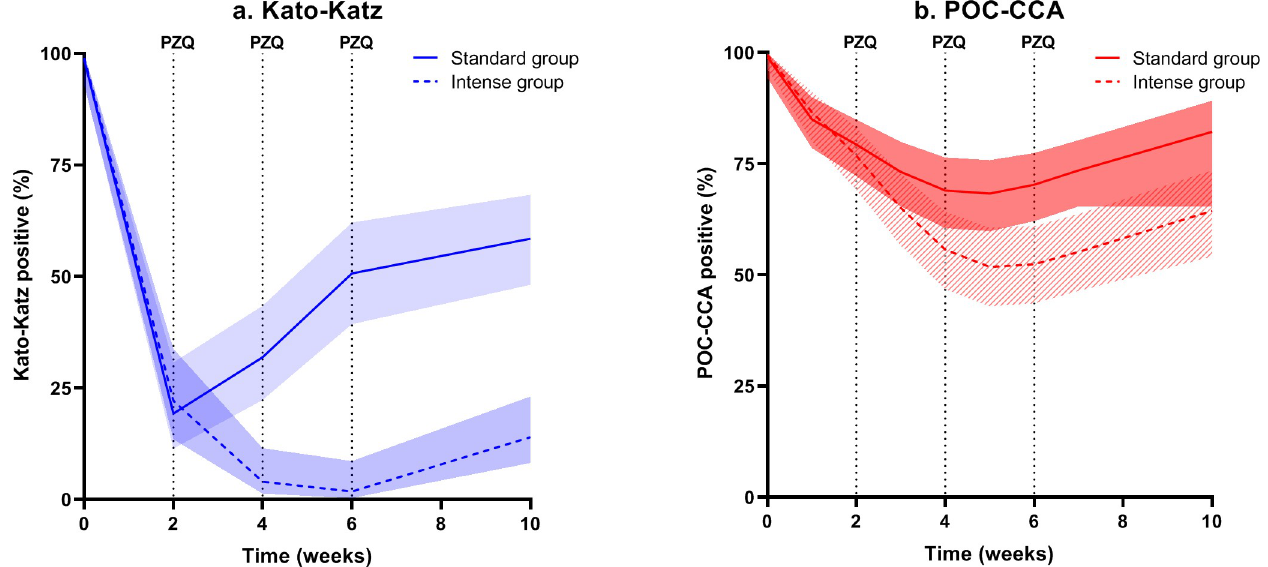
Fig 2. Prevalence over time (with corresponding pointwise 95% confidence intervals) estimated from the mixed effects logistic regression model. Data pertain to (a) triplicate Kato-Katz (KK) thick smears from a single stool sample and (b) single point-of-care circulating cathodic antigen (POC-CCA) urine test in the standard treatment group (single dose of PZQ, solid line) and the intense treatment group (four doses of PZQ at W0, W2, W4, and W6, dashed line).